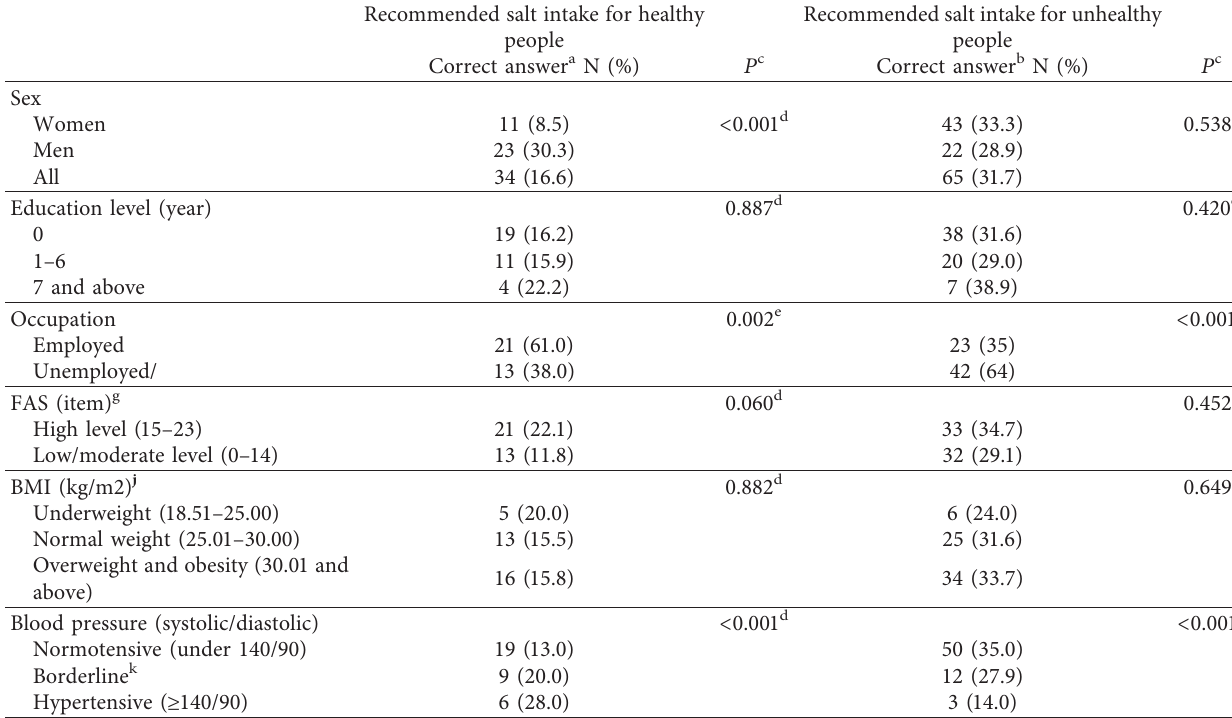
Table 5: Patient knowledge on the recommended salt intake for healthy and unhealthy